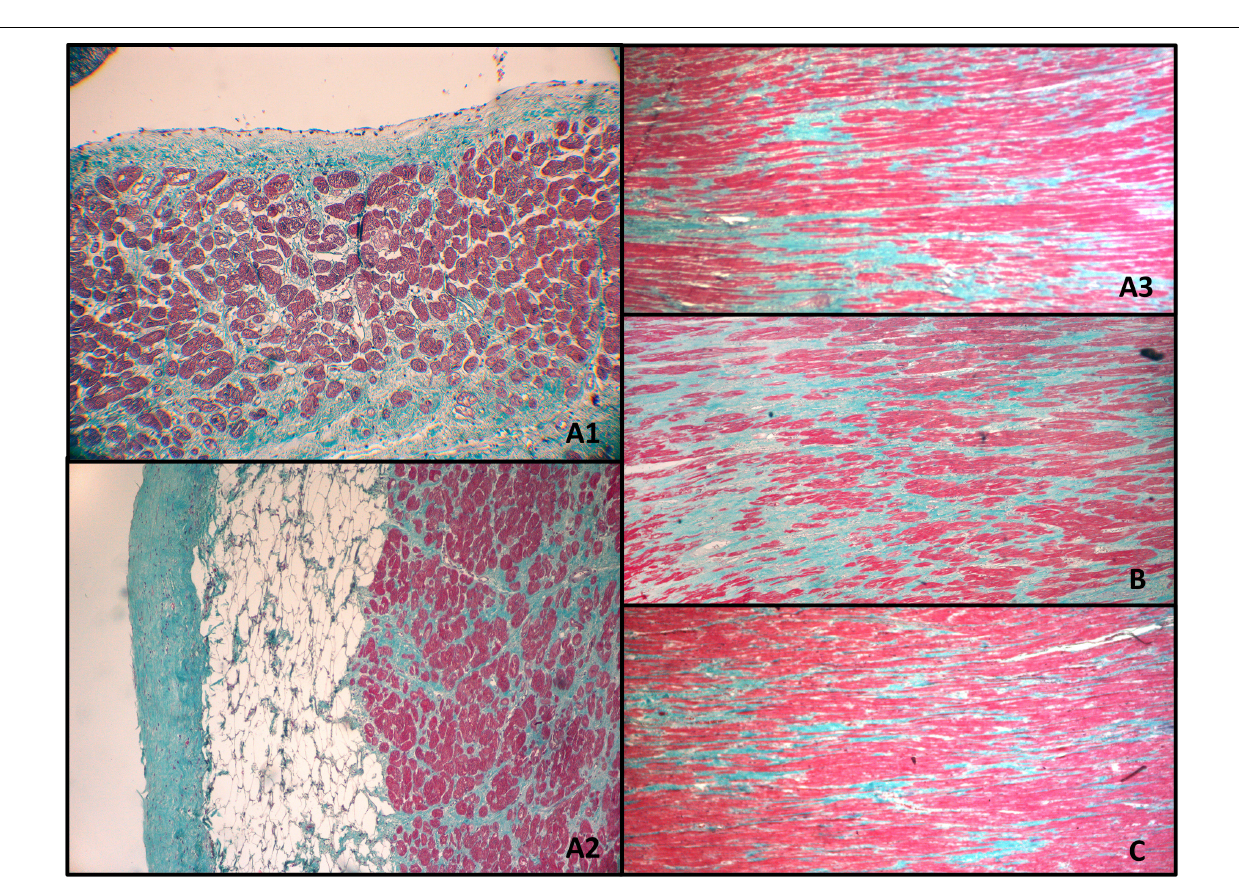
FIGURE 6 | Myocardium 12 months after transmural irradiation with a single dose of 25 Gy. The letters indicate the localization of the specimens as shown in Figure 4 . Figures (A1–A3,B) were located within the PTV and received approximately 25 Gy, while (C) was taken from a non-irradiated region. (A1) Endocardium; (A2) epicardium; (A3) middle part of the myocardium; (B) middle part of the myocardium; (C) middle part of the myocardium (non-irradiated